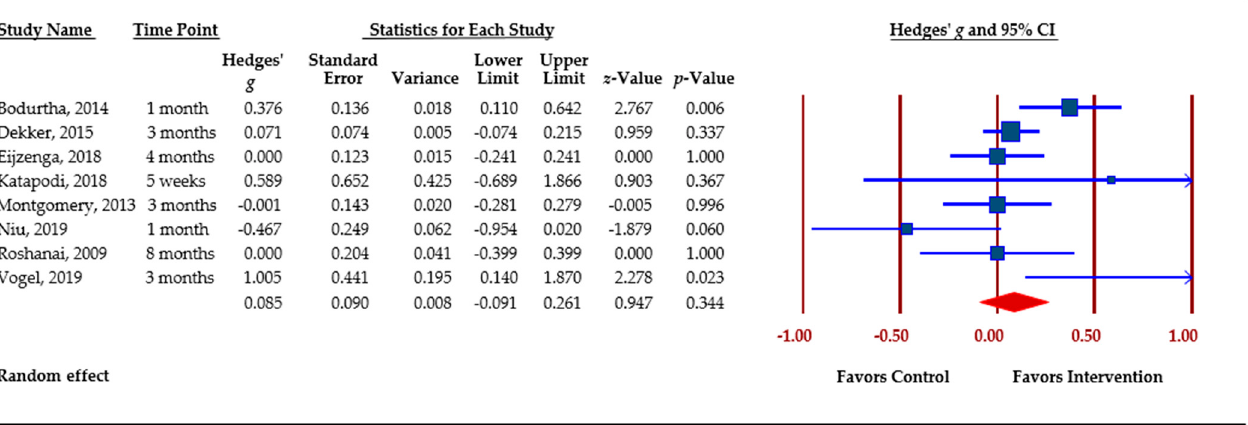
Table 3. Pooled effect sizes of outcomes.